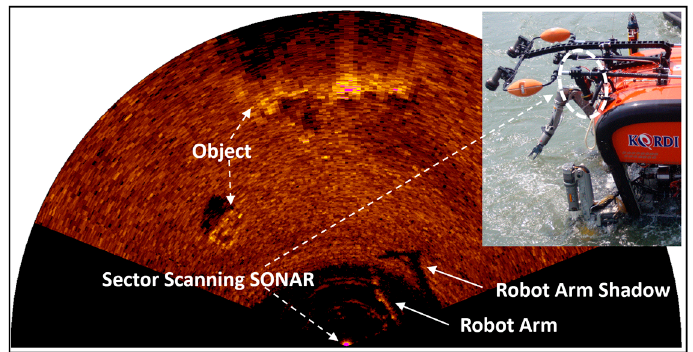
Figure 7. Sector-scanning sonar application of a work-class remotely operated vehicle (ROV).